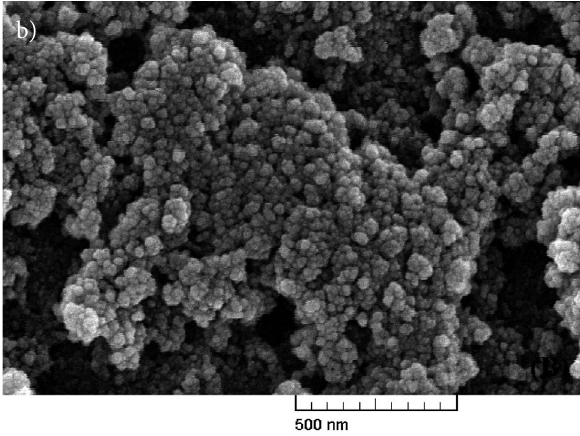
General procedure for the synthesis of tailor-made random poly (styrene-co-methyl methacrylate) chains via SR&NI ATRP in the presence of H-SAN is shown in figure